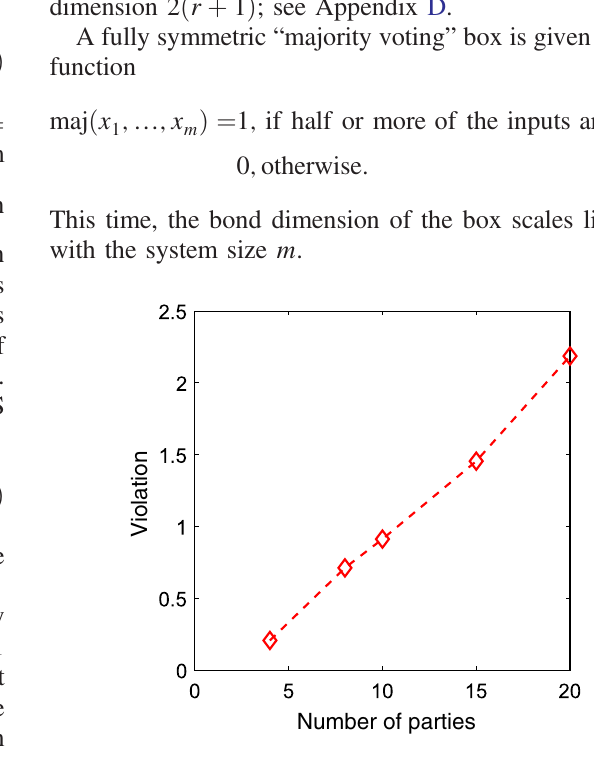
FIG. 15. Quantum nonlocality violation of the box defined in Eq. (37) with r ¼ 2 . Maximum bond dimension ¼ ð 4 4 Þ .